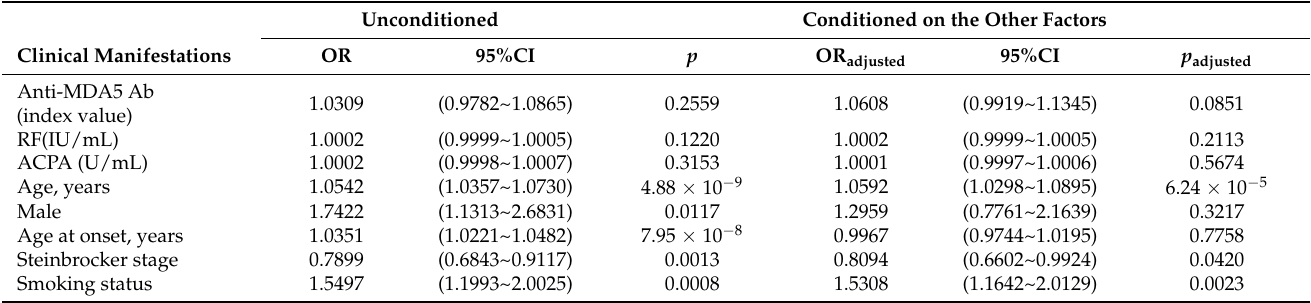
Table 3. Multiple logistic regression analysis of Abs and clinical manifestations for RA with